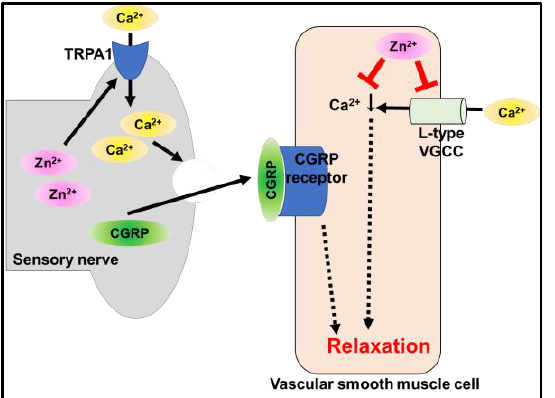
Figure 6. Mechanism of zinc-mediated vasorelaxation. Sensory nerve zinc promotes Ca 2+ influx in transient receptor potential ankyrin 1 (TRPA1), and the influx of Ca 2+ causes calcitonin gene-related peptide (CGRP) release. The released CGRP binds to the CGRP receptors in smooth muscles, causing smooth muscle relaxation. On the other hand, smooth-muscle zinc causes smooth muscle relaxation by inhibiting Ca 2+ influx through L-type voltage-gated calcium channels (VGCC).